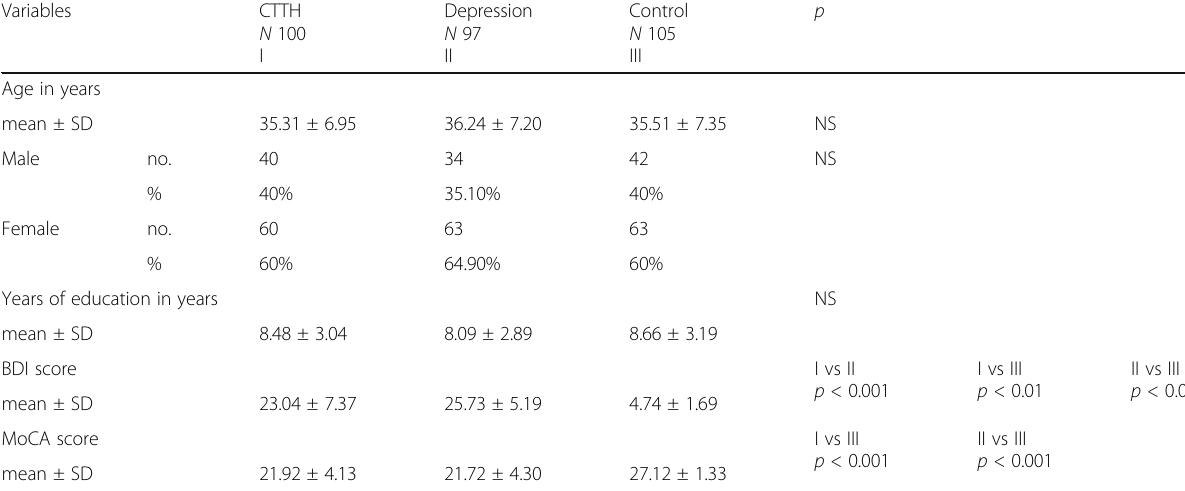
Table 1 Demographic characteristics of the subjects Variables